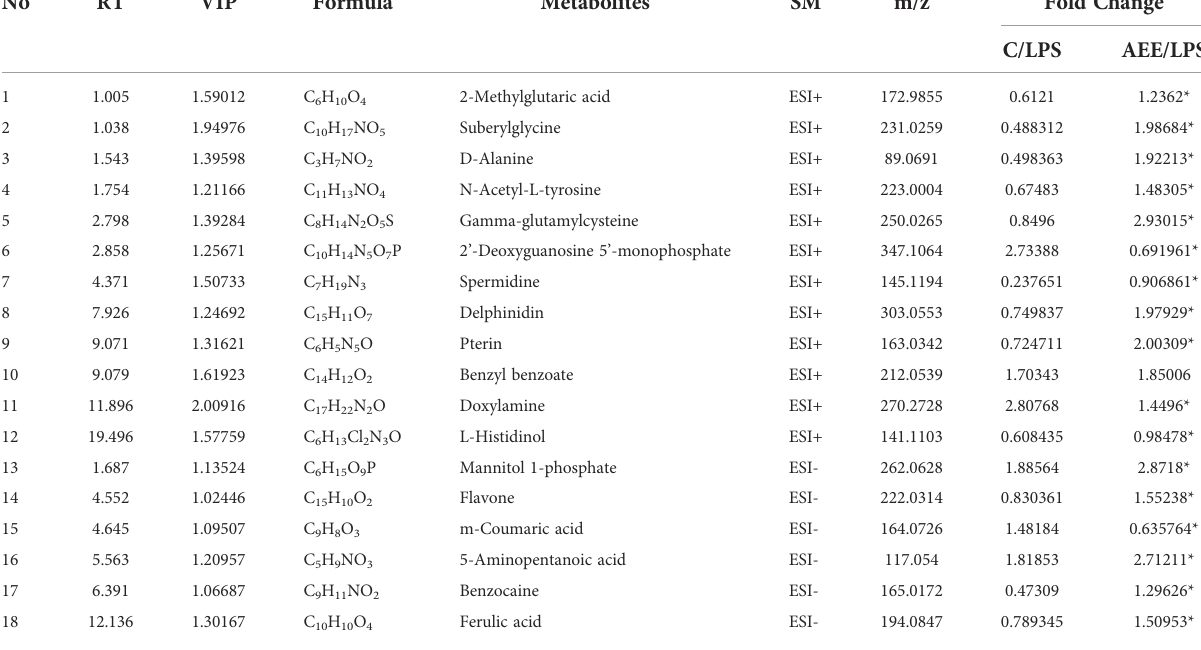
TABLE 1 Statistics of differential metabolites in serum of rats.